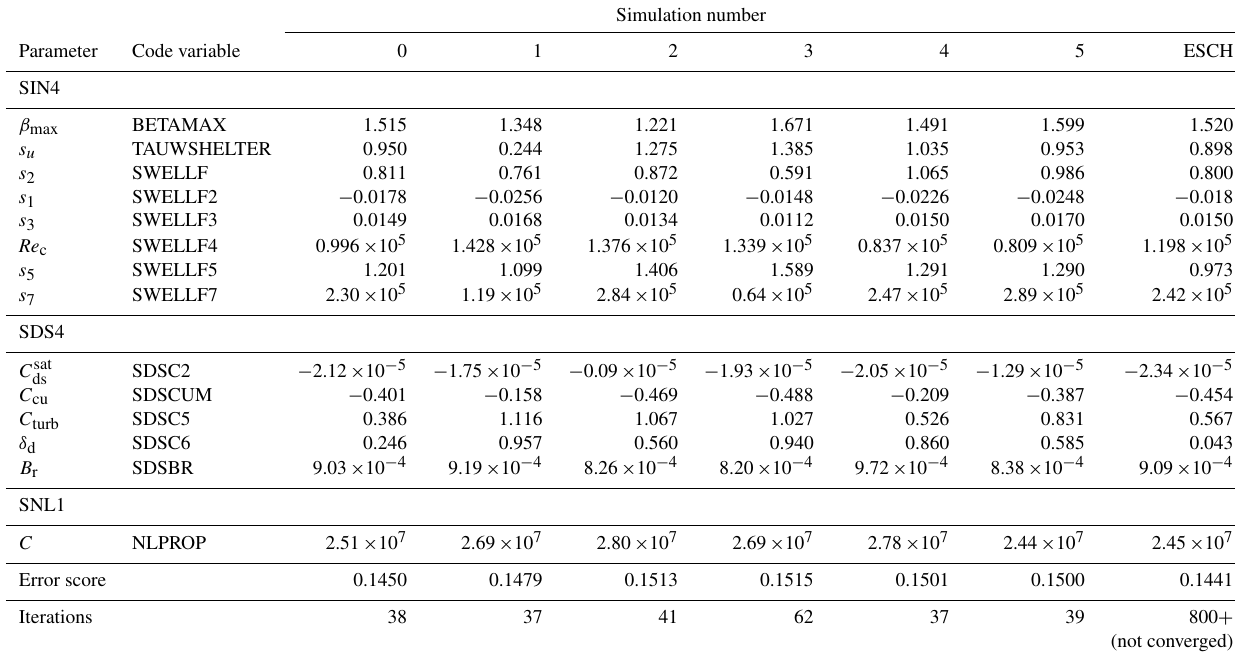
Table 5. Final values of parameters from simulations using the source term package of Ardhuin et al. (2010), for February 1997, using BOBYQA with randomised initial conditions (simulations 1–5) and using ESCH with default initial parameters. Simulation 0 is the control case, using BOBYQA with default initial